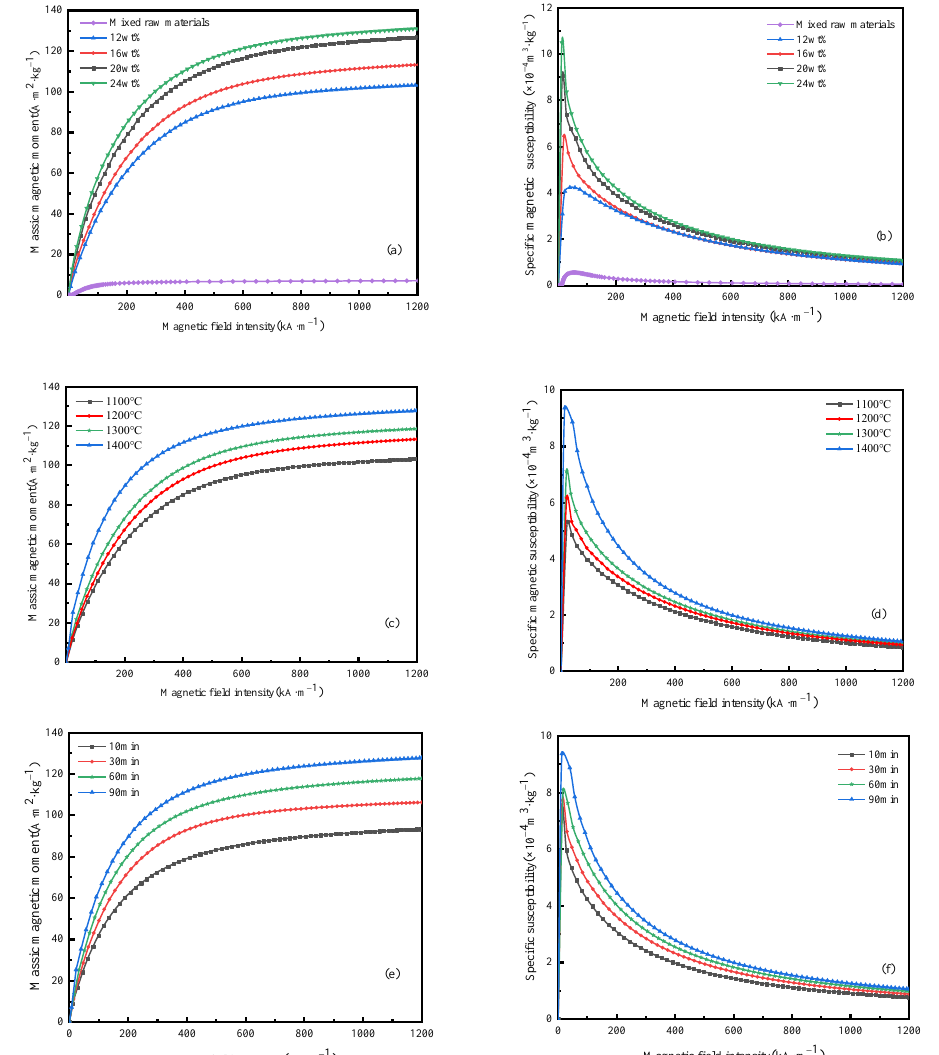
Figure 10. Magnetic moment ( a , c , e ) and specific magnetic susceptibility ( b , d , f ) of mixed raw material and reduction products obtained at various reduction conditions: ( a , b ) anthracite dosage; ( c , d ) reduction temperature; ( e , f ) reduction time.